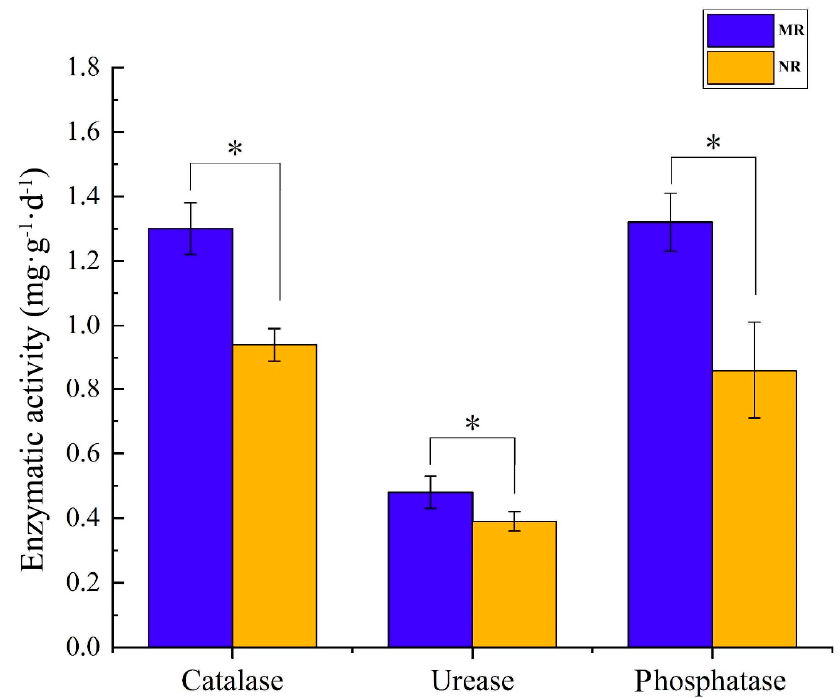
Figure 6. The activities of catalase, urease, and phosphatase in the mycorrhizal rhizosphere of S. luteus and non-mycorrhizal rhizosphere. “*” indicates significant differences ( n = 3, p < 0.05).